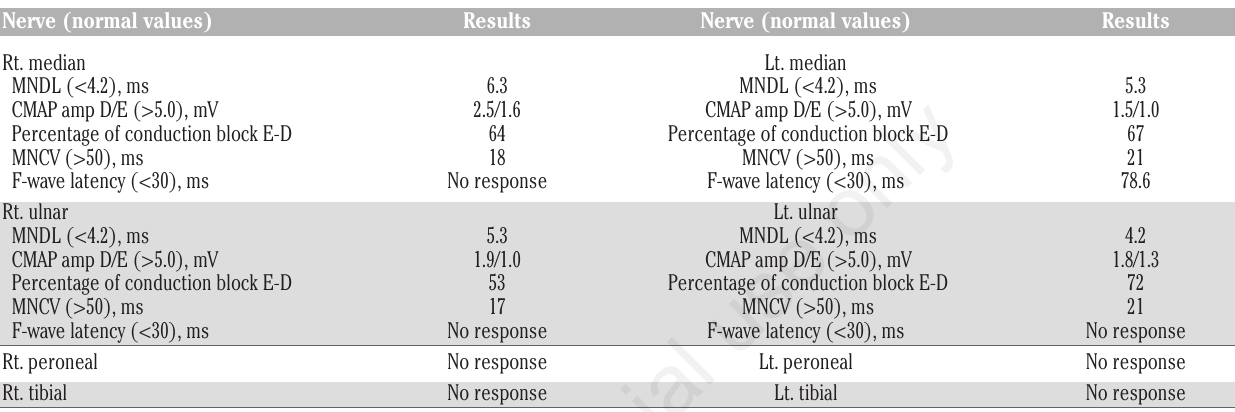
Table 2. Results of the motor nerve conduction study.